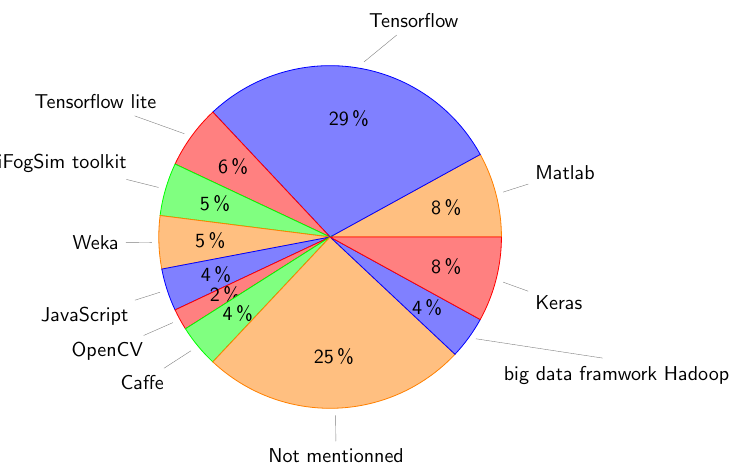
Figure 7. Platforms and software